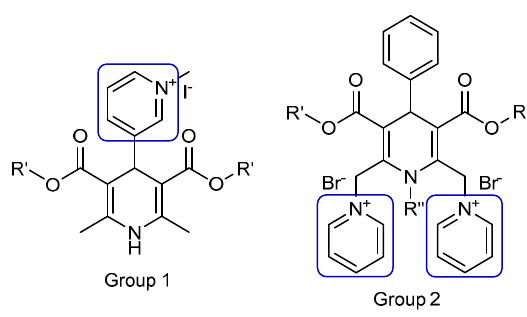
Figure 1. Nanoparticle forming gene delivery systems—amphiphiles on the base of 1,4-dihydropyridine (1,4-DHP) with single (Group 1) and double (Group 2) pyridinium moieties. (Modified from [18]).